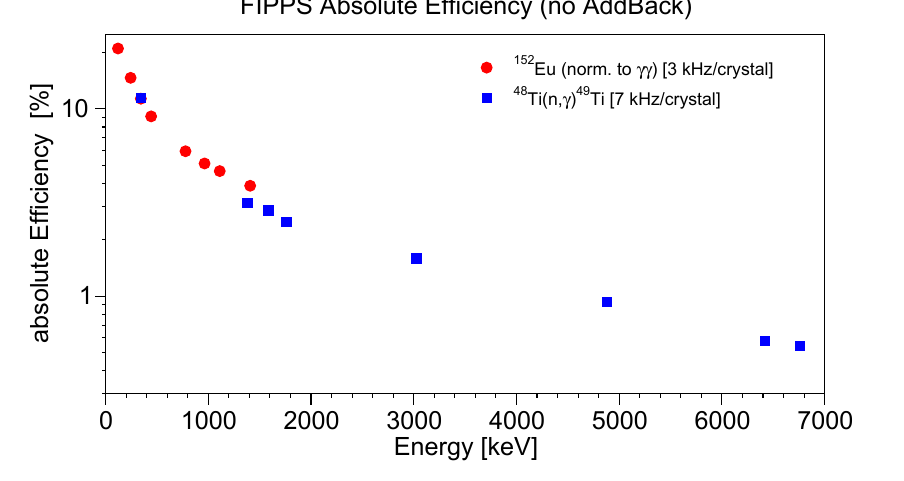
Figure 4: E ffi ciency curve obtained using a 152 Eu calibration source and from in-beam data from γ coincidences in 152 Eu. the 48 Ti(n, γ ) 49 Ti reaction, normalized to the e ffi ciency extracted from γ − Spectra obtained without using add-back treatment of the data have been used for this analysis. The discrepancy observed at 1.4 MeV between the two data sets is due to summing e ff ects in the Ti data, ≈ not corrected in this